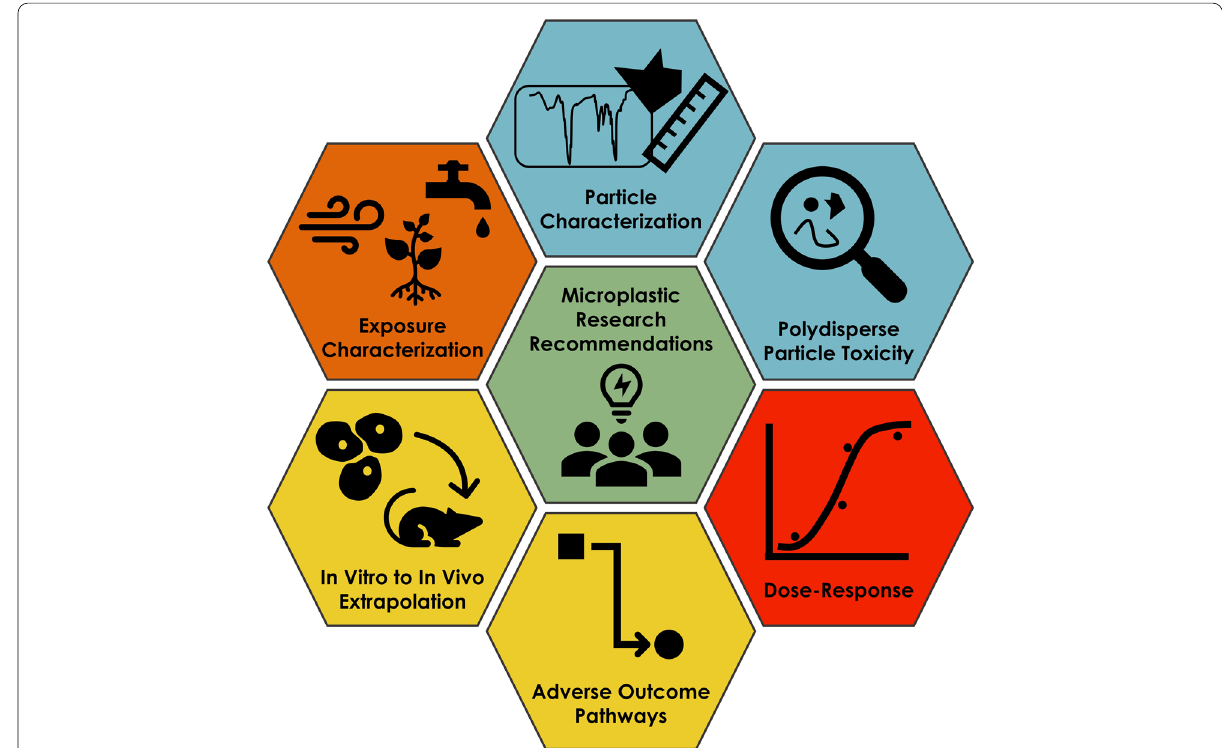
Fig. 1 Visual summary of key research recommendations for microplastic hazard